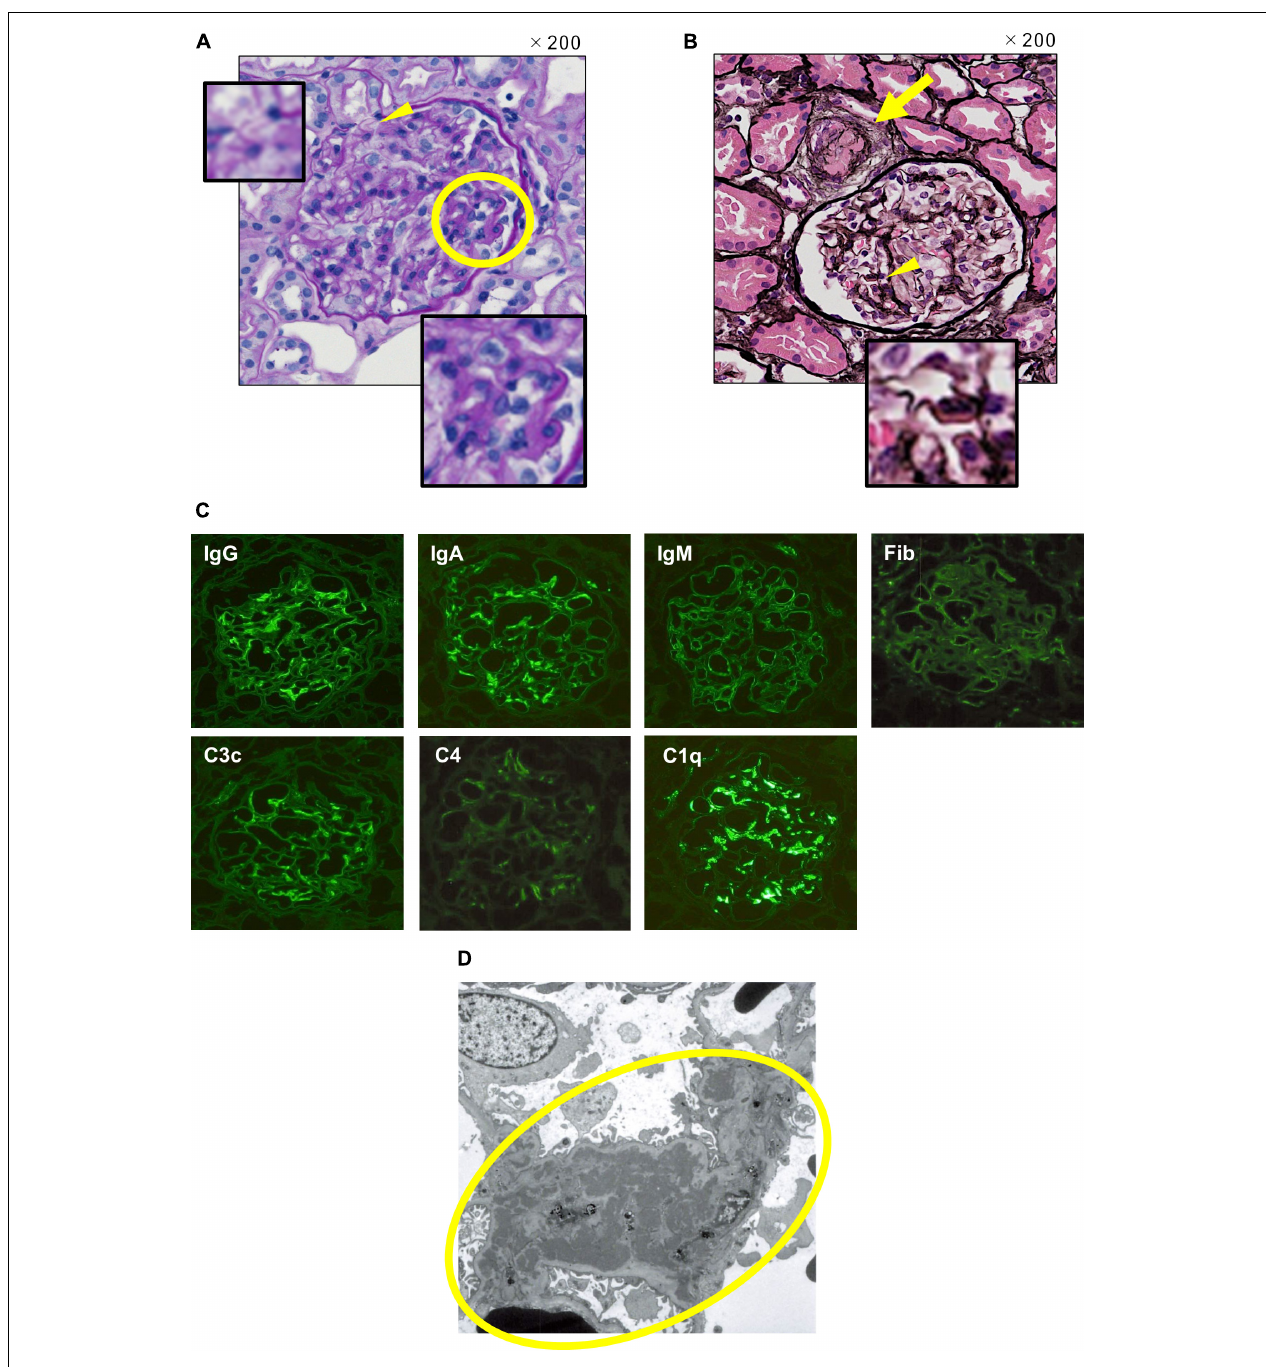
FIGURE 2 | Renal pathology. (A) Light microscopy. Periodic acid Schiff stain, original magnification 200 × . A wire loop lesion and endocapillary hypercellularity (the yellow circle), and duplication in glomerular basement membrane (the yellow arrowhead) are observed. (B) Light microscopy. Periodic acid silver-methenamin + hematoxylin-eosin staining, original magnification 200 × . Thrombus formation with luminal stenosis in afferent arteriole (the yellow arrow) and wire loop lesion (the yellow arrowhead) are observed. (C) Immunofluorescent staining. Full-house positive staining at the capillary wall and, mainly, in the paramesangial region is shown. (D) Electronic microscopy. Electron-dense deposits in the paramesangial region (the yellow circle) are observed comparable to IF findings.